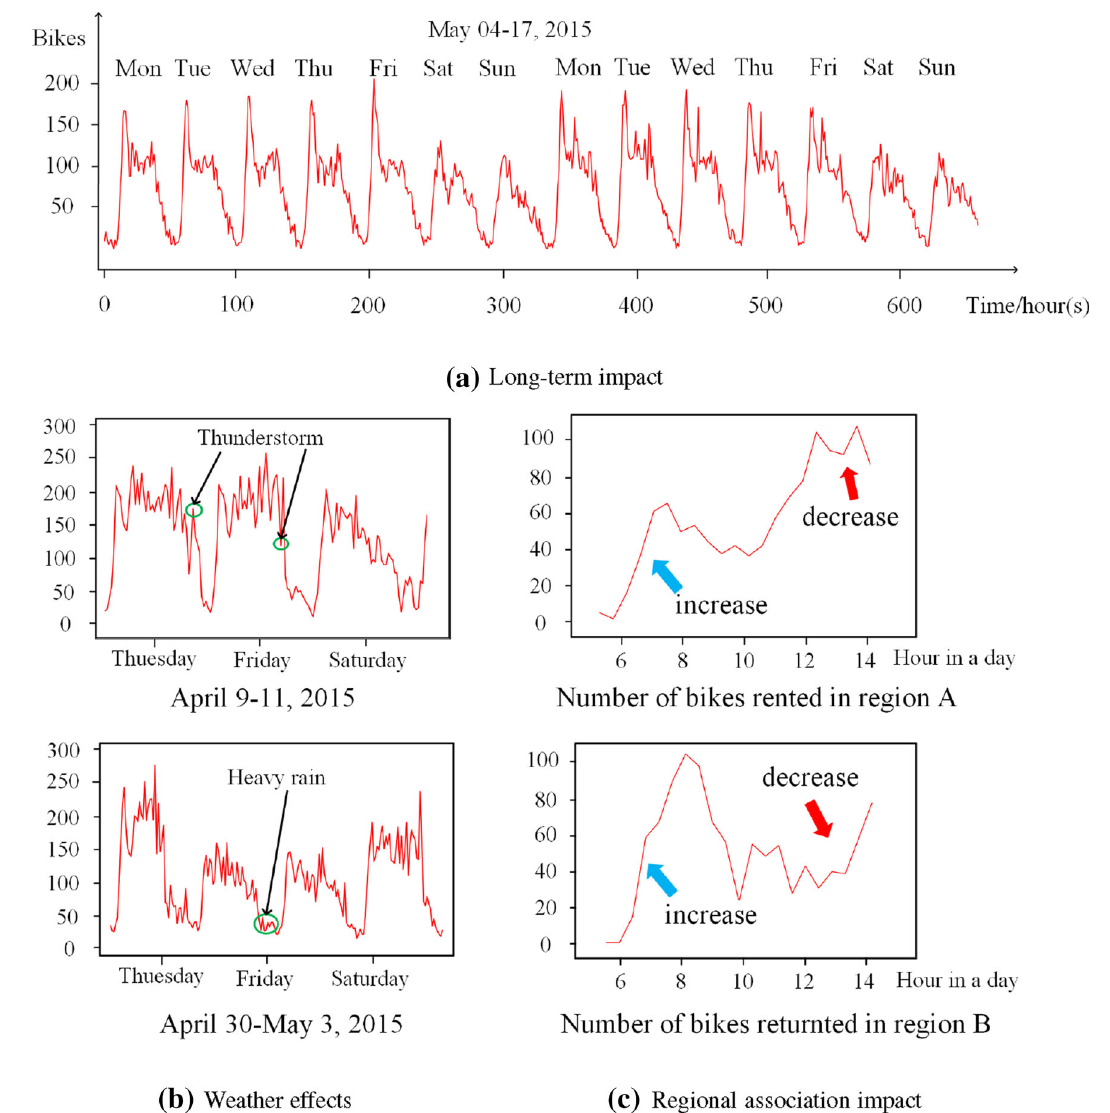
Fig. 2 Factors affecting the use of shared bicycles